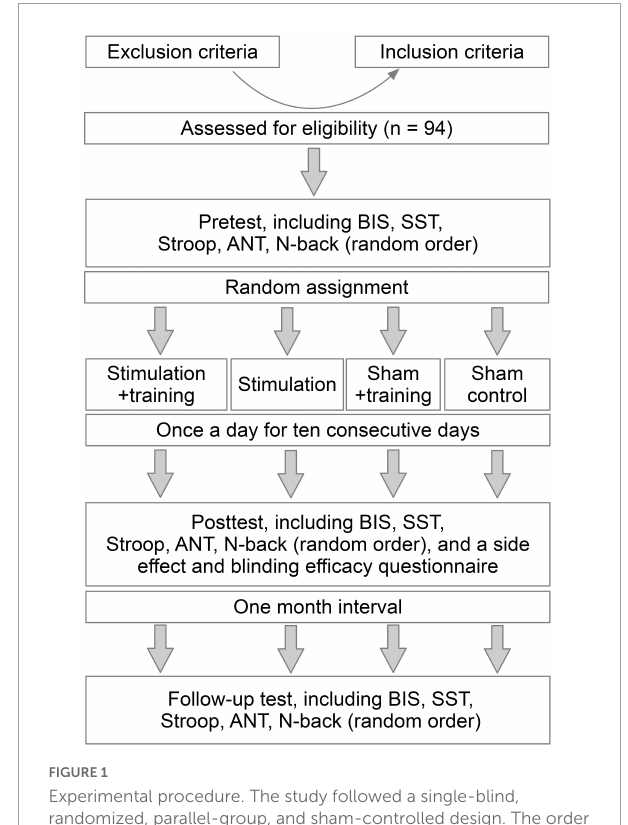
FIGURE1 Experimental procedure. The study followed a single-blind, randomized, parallel-group, and sham-controlled design. The order of SST, Stroop task, ANT, and N-back task were randomized.